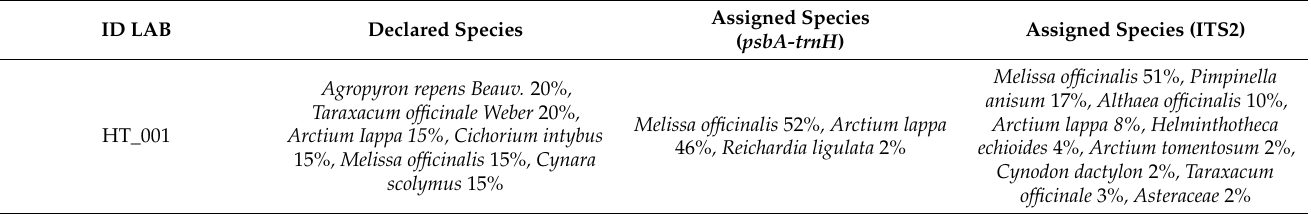
Figure 2. Relative abundance of the plant taxa recovered in the 15 herbal tea products through psbA-trnH metabarcoding sequencing. Only the taxa present in at least two of the three replicas and in a concentration > 1% are shown. The complete list of taxa is reported in Supplementary Table S1. Table 1. List of the detected ingredients in market samples, based on DNA metabarcoding assignment. For each sample, the declared species, assigned species for the DNA barcode marker psbA-trnH and ITS2 and the company are indicated. The percentage values refer to the relative abundance of HTS sequences for each recognized ingredient. Percentage and plants (indicated as scientific or common name) of declared species are reported as indicated in the commercial label. The chosen taxa in the table were present in at least two out of three replicates.